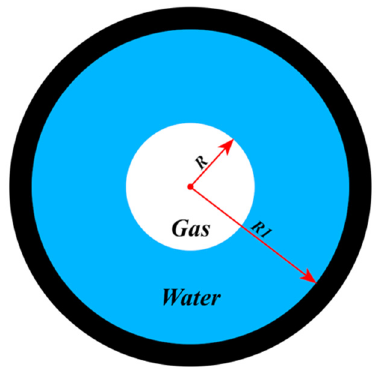
Figure 2. Schematic view of the modelled annular regime in two-phase flow.